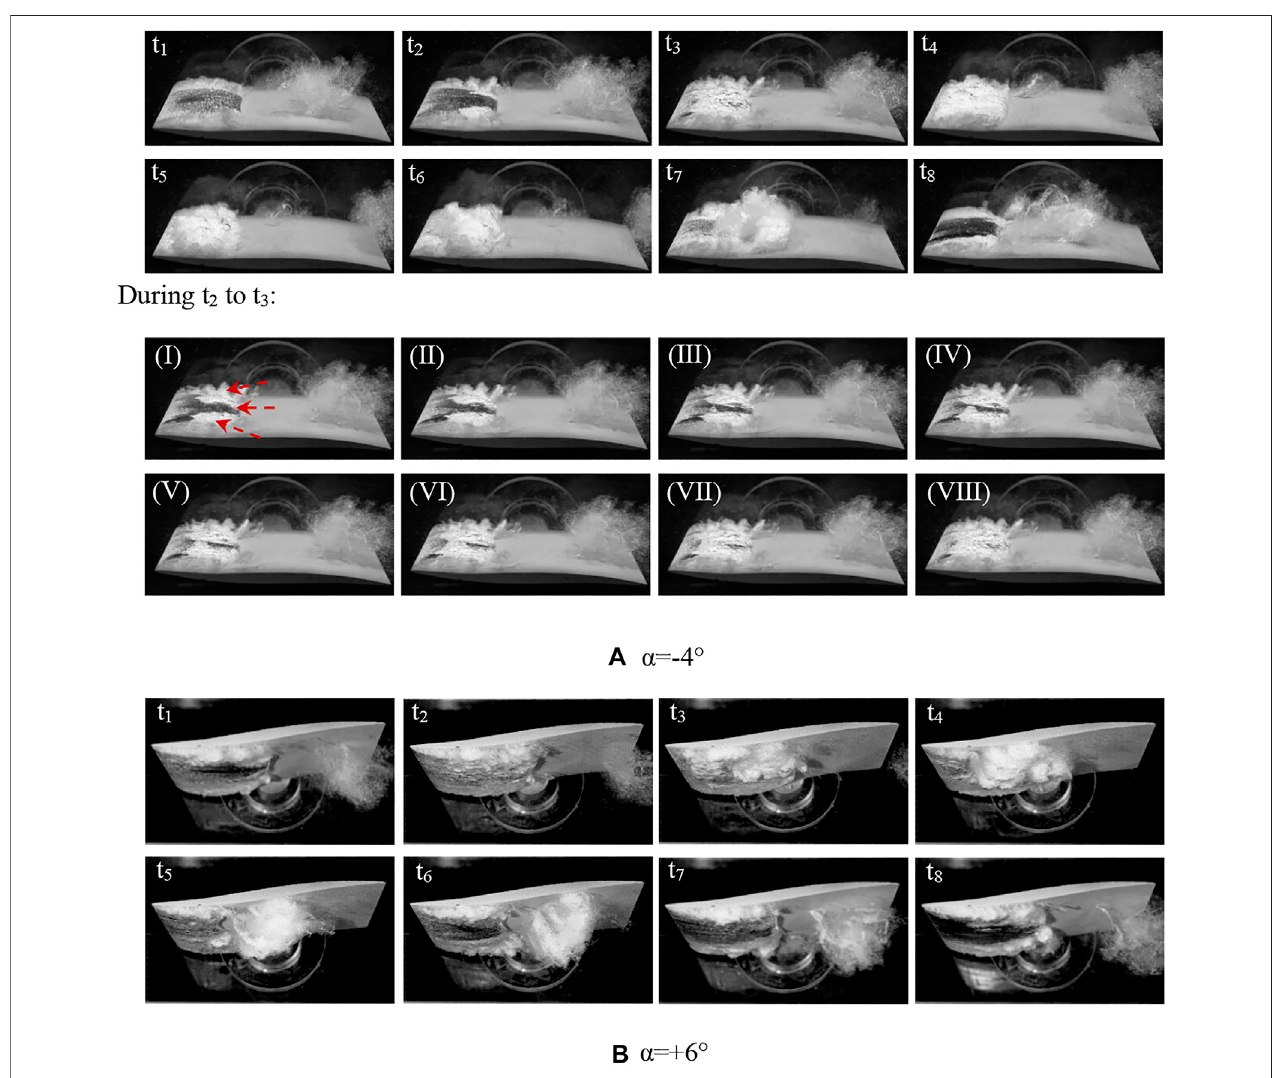
FIGURE 7 | The dynamic evolution of cloud cavitation (U ∞ (cid:1) 9 m/s).